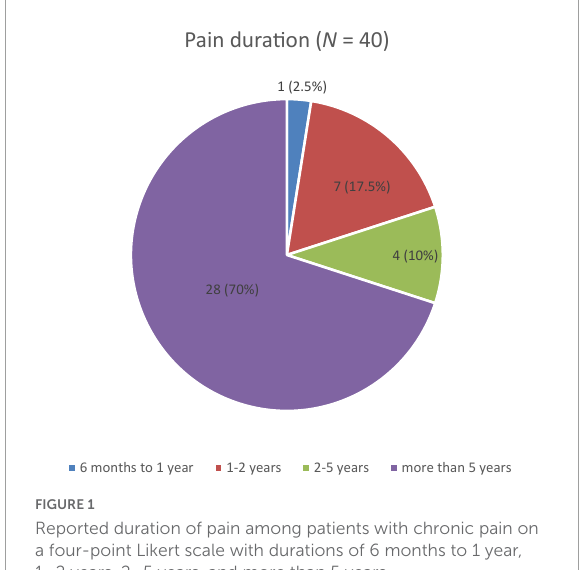
FIGURE1 Reported duration of pain among patients with chronic pain on a four-point Likert scale with durations of 6 months to 1 year, 1–2 years, 2–5 years, and more than 5 years.